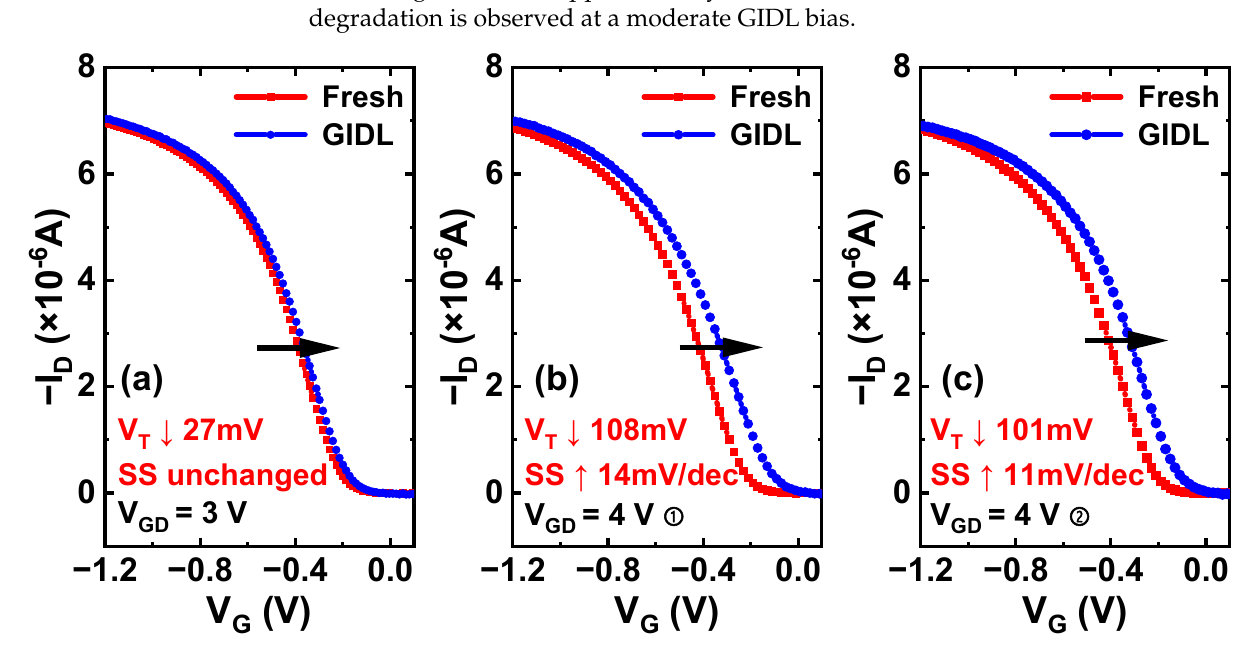
Figure 5. Pulse-IV curves of fresh p-FinFETs before and after 1 ks GIDL biases for ( a ) V GD = 3 V: V G,GIDL = 0.5 V, V D,GIDL = − 2.5 V; ( b ) V GD = 4 V ① : V G,GIDL = 1.5 V, V D,GIDL = − 2.5 V; and ( c ) V GD = 4 V ② : V G,GIDL = 0.5 V, V D,GIDL = − 3.5 V.